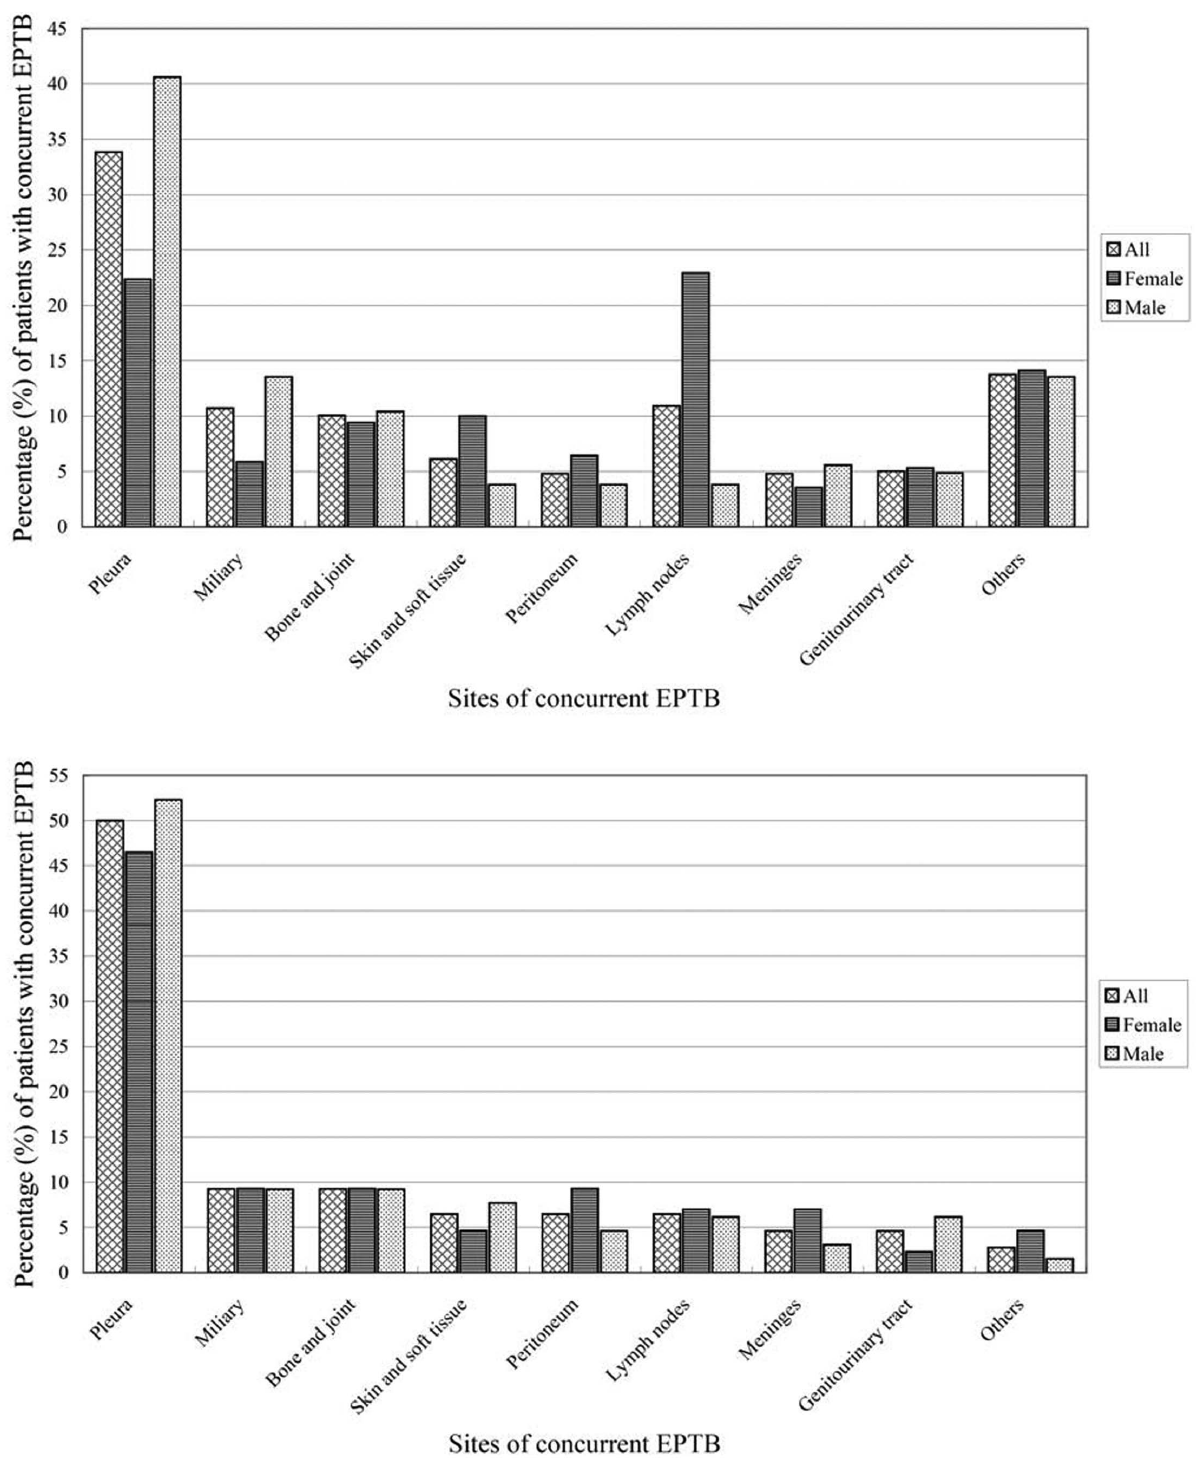
Figure 1. Sites of concurrent EPTB involved among patients with PTB, from the NHI database (upper panel) and the KMUH database (lower panel).